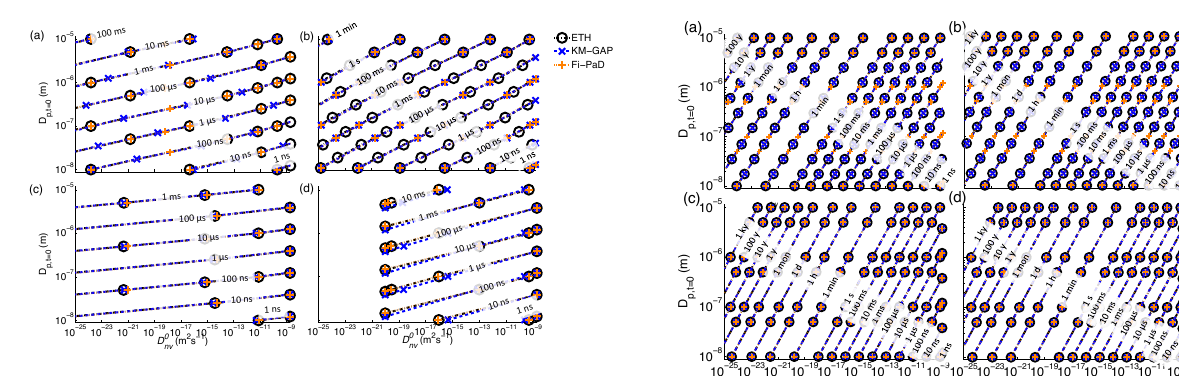
Figure 3. e -folding time contour plots for different changes to the saturation ratio of the semi-volatile component ( (cid:49)e s ) and dif- ferent diffusion coefficient dependencies: (a) (cid:49)e s = 1–90% log- arithmic dependence, (b) (cid:49)e s = 90–1%, logarithmic dependence, (c) (cid:49)e s = 1–90%, sigmoidal dependence, and (d) (cid:49)e s = 90–1% sigmoidal dependence. D 0 nv is the diffusion coefficient at a semi- volatile mole fraction of 0, while D 0 sv (diffusion coefficient at a semi-volatile mole fraction of 1) was fixed at 2.0 × 10 − 9 m 2 s − 1 . 2.0 × 10 − 9 m 2 s − 1 at x sv = 1 and a minimum given by D 0